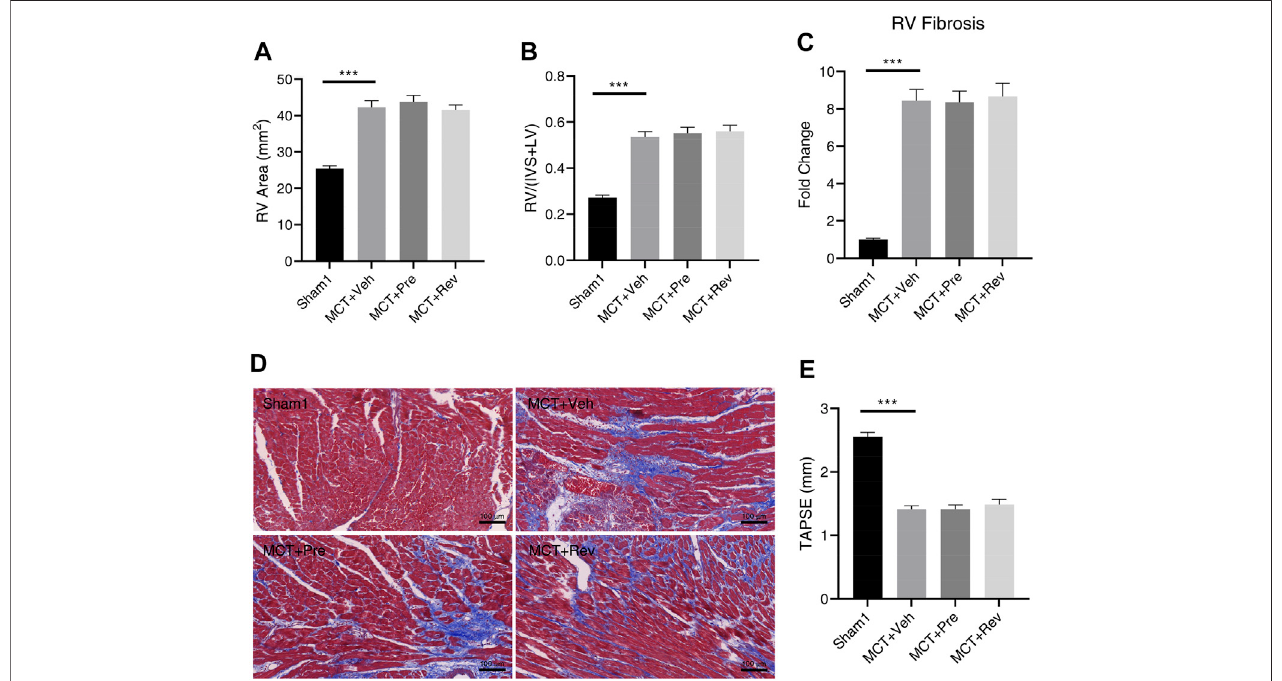
FIGURE5| Dapagli fl ozincouldnotattenuateRVremodelingorimproveRVdysfunctioninMCTrats.Quanti fi cationofRVarea (A) ,RV/(IVS+LV) (B) ,RV fi brosis (C) , and TAPSE (E) fi ve weeks after MCT injection; (D) Representative images of Masson staining in the cardiac sections. (*** p < 0.001; n (cid:1) 6 for Sham1, n (cid:1) 10 for MCT + vehicle, MCT + prevention, and MCT +